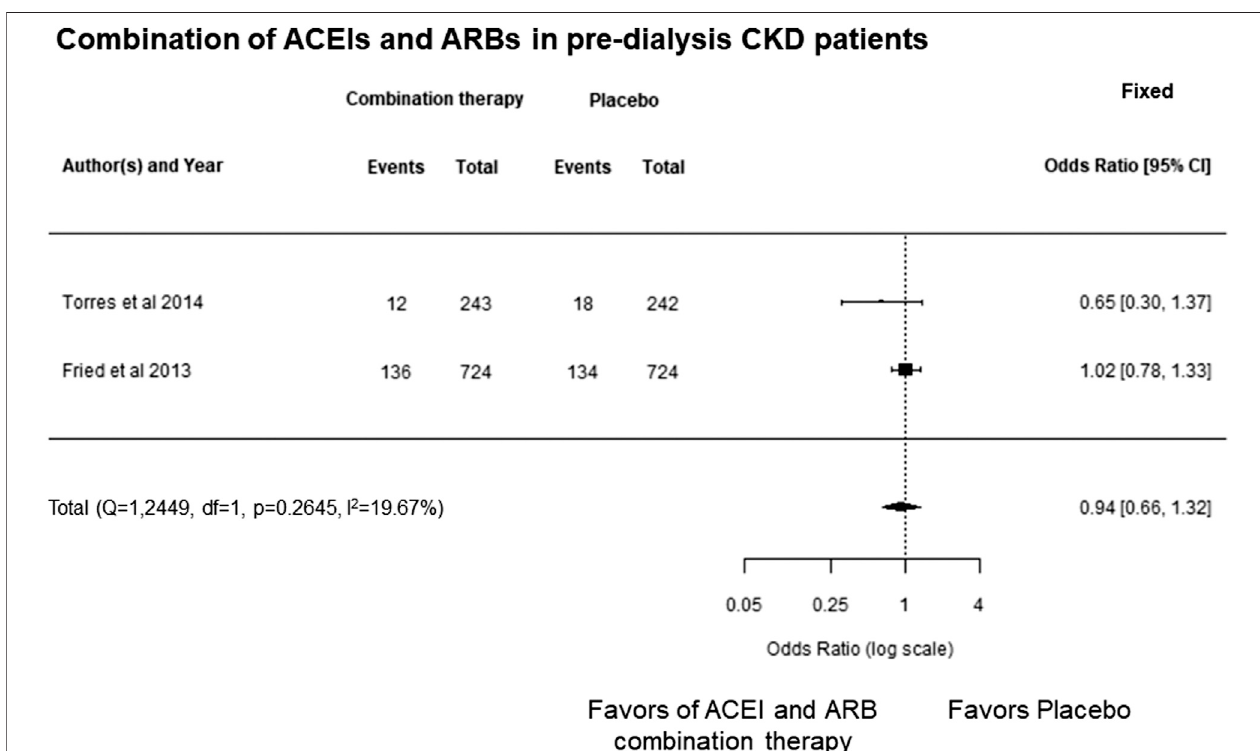
FIGURE 6 | Forest plot describing a comparison of the incidence of cardiovascular events between combination therapy with ARBs and ACEIs and placebo in pre- dialysis patients with CKD. ACEIs, angiotensin converting enzyme inhibitors; ARBs, angiotensin receptor blockers; CI, con fi dence intervals; CKD, chronic kidney disease.